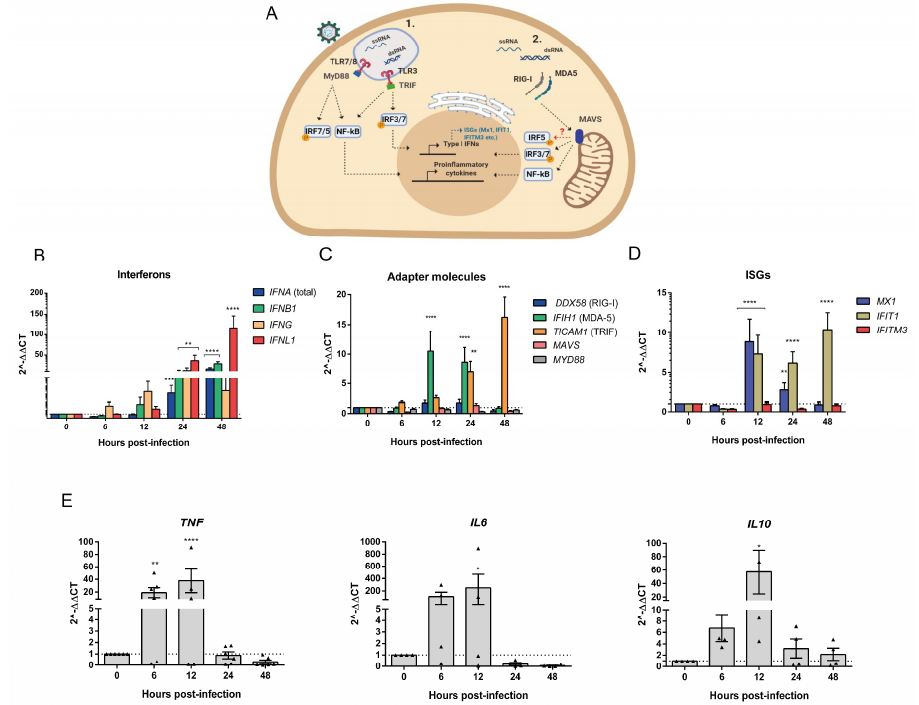
Figure 4 Figure 4. OROV infection of PBMCs induces the expression of cytokines and innate immune response genes. Cell lysates from PBMCs obtained from healthy donors ( n = 3) and infected with OROV at MOI 10 were processed for RNA extraction and RT-PCR. ( A ) Scheme of the RNA PAMPs recognition pathways analyzed. ( B – E ) SYBR Green qRT-PCR data analysis of gene expression are shown in fold change (2ˆ ∆∆ C T). Graphics show results from two independent experiments. Bars represent mean ± SEM. All times post-infection were compared to the time 0 h samples (noninfected) by two-way ANOVA and Dunnett’s multiple comparisons test. **** p -value < 0.0001; *** 0.0002 < p -value < 0.0007; ** 0.001 < p -value < 0.009; and * p -value <